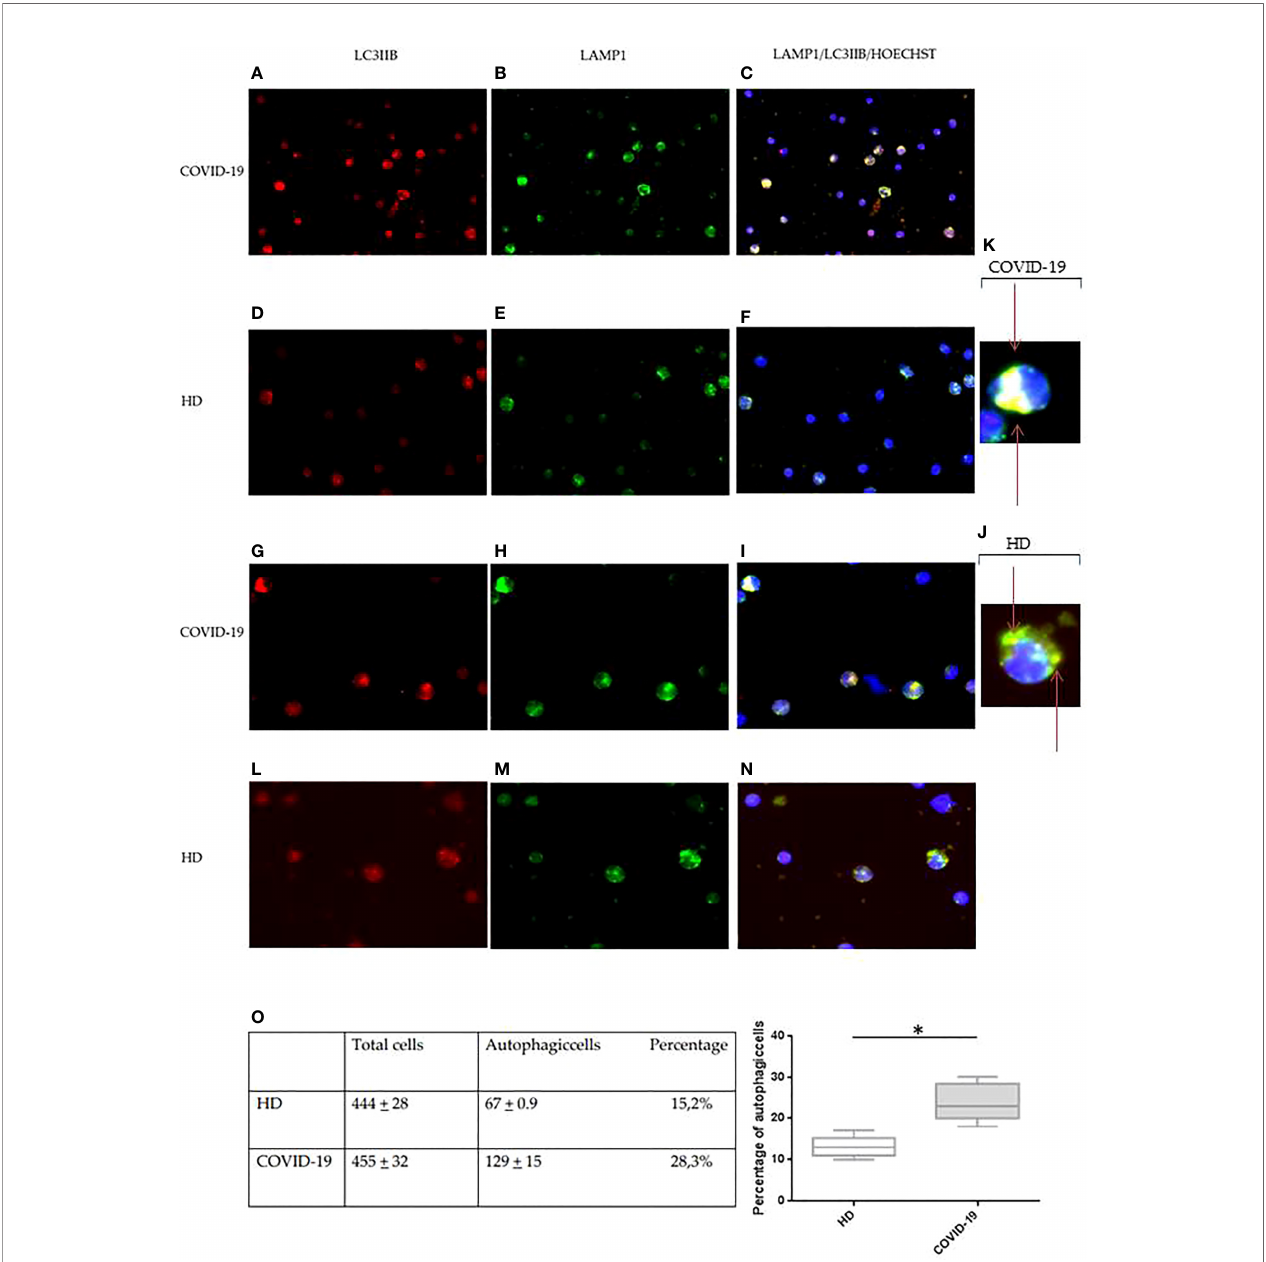
FIGURE 4 | Immuno fl uorescence analysis of autophagy in PBMCs from COVID-19 patients and HDs. LC3IIB (red fl uorescence) and LAMP1 (green fl uorescence) expression in PBMCs from COVID-19 patients (A, B, G, H) and HDs (D, E, L, M) . Intracellular autophagolysosome formation detection by colocalization between LC3IIB and LAMP1 (yellow fl uorescence) in PBMCs from COVID-19 patients (C, I) and HDs (F, N) . (A – F) Magni fi cation, 50×. (G-I, L-N) Magni fi cation, 100×. (J, K) Magni fi cation, x200. (O) Table of total cells and autophagic cells percentage and analysis of the percentage of autophagic cells in COVID-19 and HD PBMCs (Student ’ s t-test). Values are expressed as means ± SD. * p < 0.05. PBMC, peripheral blood mononuclear cell; COVID-19, coronavirus disease 2019; HDs, healthy